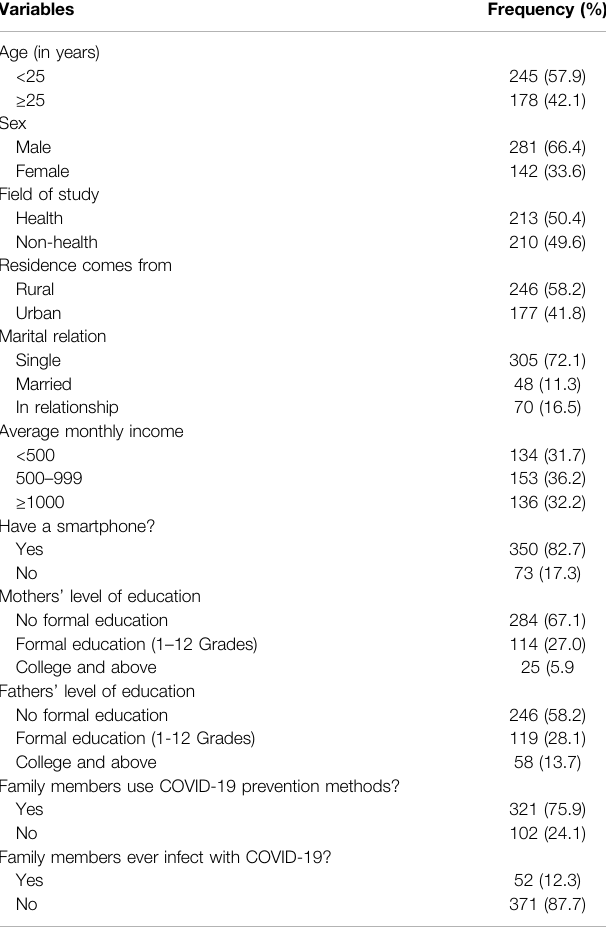
TABLE 1 | Participants ’ demographics in Debre Berhan University, Northeast Ethiopia, 2021 ( n (cid:1) 423).